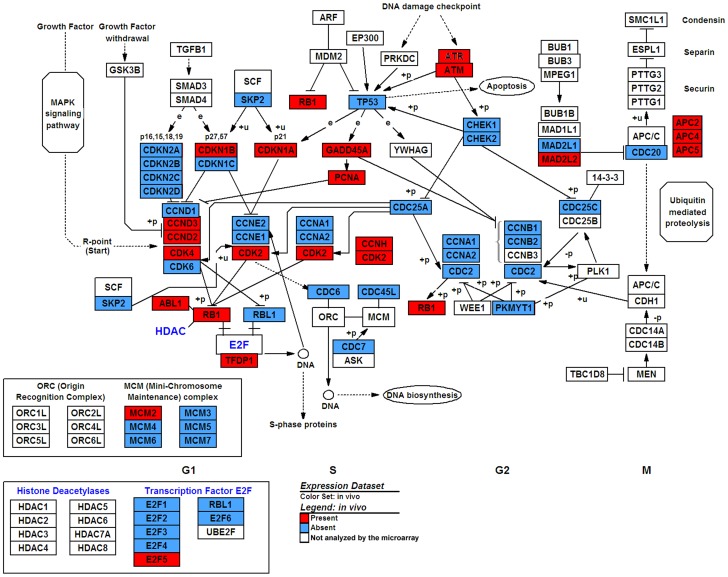
Baseline cell cycle gene expression profile in human corneal endothelial cells in vivo.Graphic representation of the presence/absence of gene expression on KEGG cell cycle pathway using GenMAPP version 2.1 (http://www.genmapp.org/).